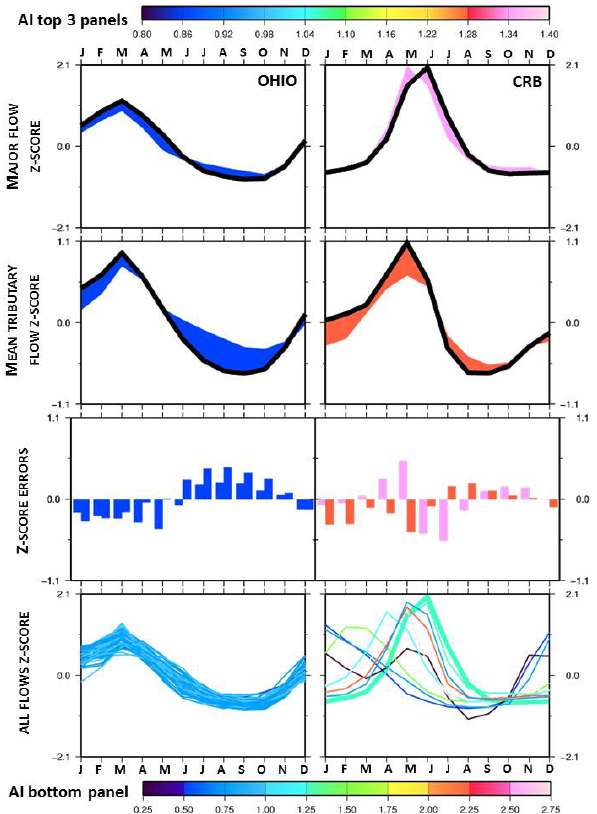
Figure 13: Comparison between major basin and mean tributary flows and errors. Flow data was converted to z-scores to allow for comparison among basins. The differences in aridity index (AI) are shaded according to the upper-scale for the top 3 panels and the lower scale for the bottom panel.